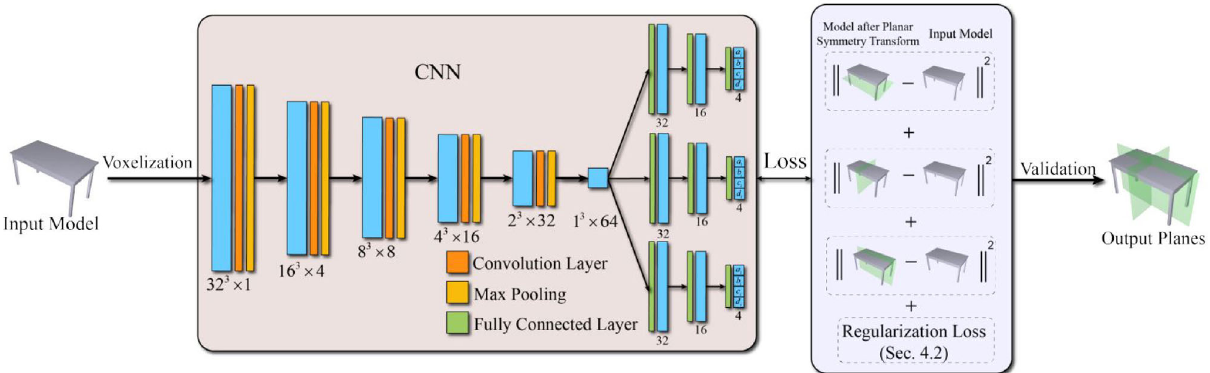
Fig. 6 Pipeline of PRS-Net. Reproduced with permission from Ref.